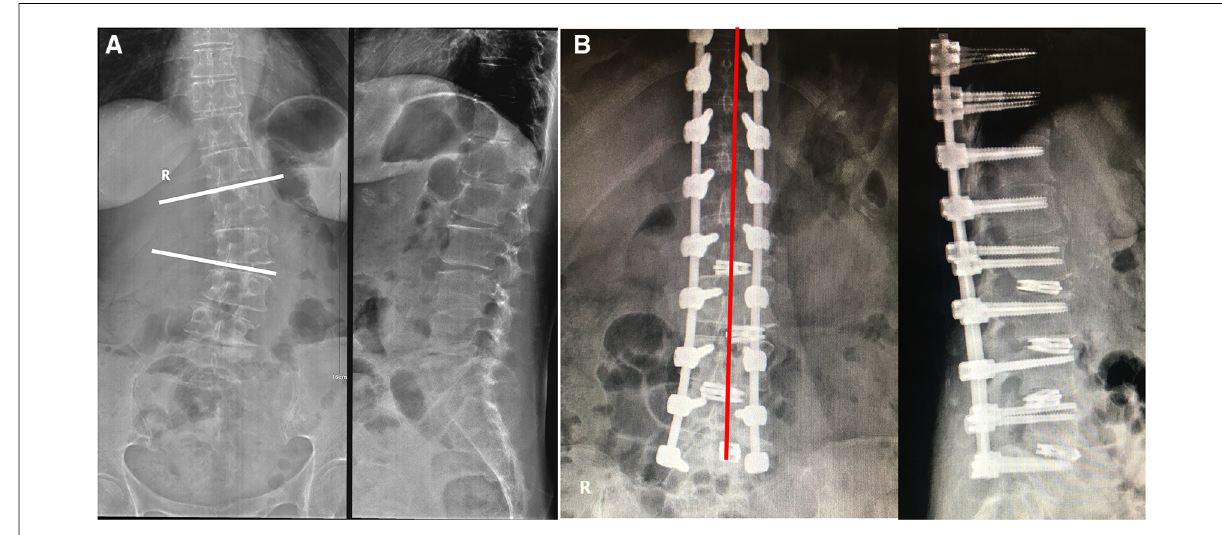
FIGURE 2 X-rays of the 61-year-old female patient with ADS, which was taken on December 2018: ( A ) before operation and ( B ) after